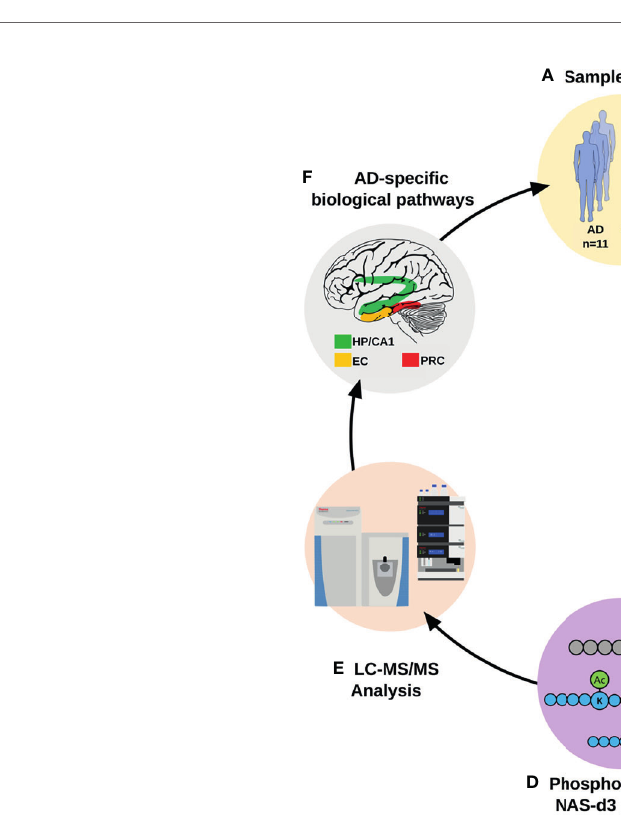
FIGURE 1 | Analytical work fl ow for the proteomic characterization of AD vulnerable brain areas. AD and control tissues from four different brain areas were isolated after histological evaluation. Proteins were extracted and subjected to a proteomics and bioinformatics work fl ow, including the characterization of changes in protein acetylation and phosphorylation patterns. (AD, Alzheimer ’ s disease; CA1, CA1 region of the hippocampal complex; EC, Entorhinal cortex; HP, Hippocampus; LC- MS/MS, liquid chromatography-tandem mass spectrometry; NAS-d3, N-acetoxy-succinimide-d3; PRC, Perirhinal